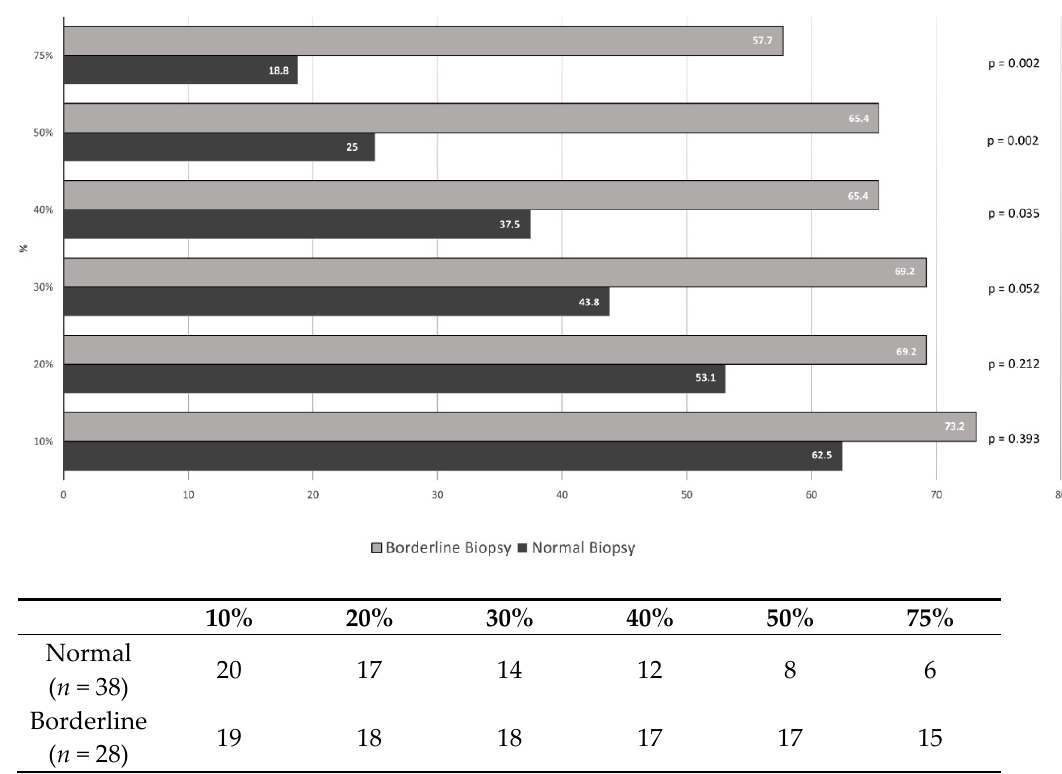
Figure 2. Difference in the CD14++CD16+ monocytes (Yes/No) in graft blood versus peripheral blood. Table 3. Logistic regression to determine risk factors associated with the appearance of borderline lesions in the protocol